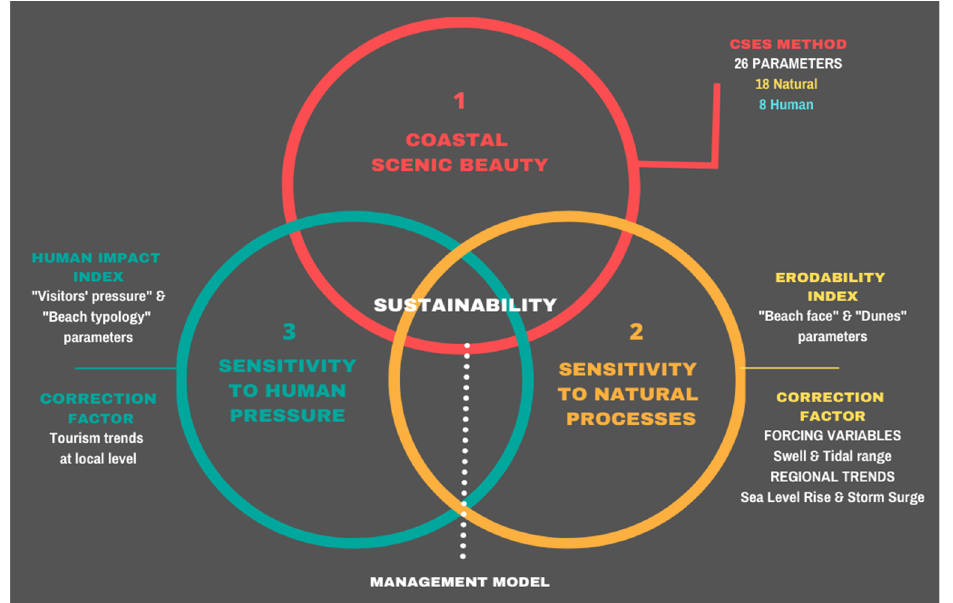
Figure 2. Summary of concepts and methods used in this paper.